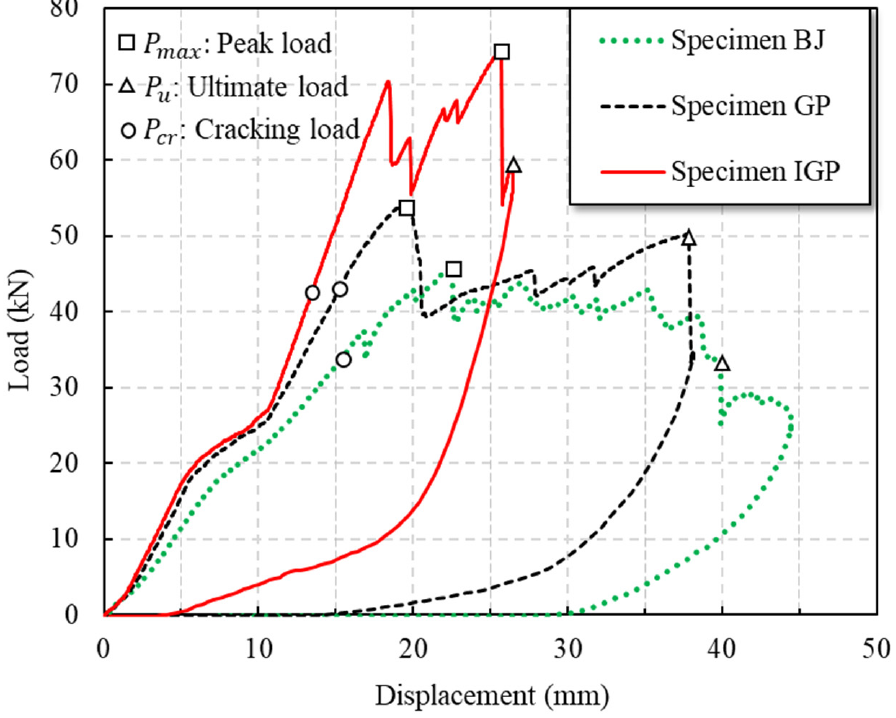
Figure 17. Load–displacement curve of GFRP truss joints. For specimen GP, cracks formed at the midspan flange of the front grooved web chord when the load reached 44.2 kN. With the increase in load, the top flange of the crack member collapsed and the deformation of the flange increased gradually. When the load reached 53.6 kN, the connection between the left web and the bottom plate of the front grooved web chord was fractured. After that, with the continuous increase in load, the vertical load was mainly carried by the hinged part of the diagonal chord. When the load decreased to around 48 kN, the pull-out failure occurred at the hinge of the right diagonal chord, resulting in the overall failure of the joint. Specimen IGP experienced its first crack at the load of 42.33 kN at the web–flange junction of the horizontal chord. With the increase in load, the crack propagated along the vertical direction and finally resulted in overall failure at the ultimate load of 54.12 kN. The peak load of specimen IGP (74.47 kN) is 62% higher than the bolted one (specimen BJ), and 38.8% higher than the typical gusset plate joint (specimen